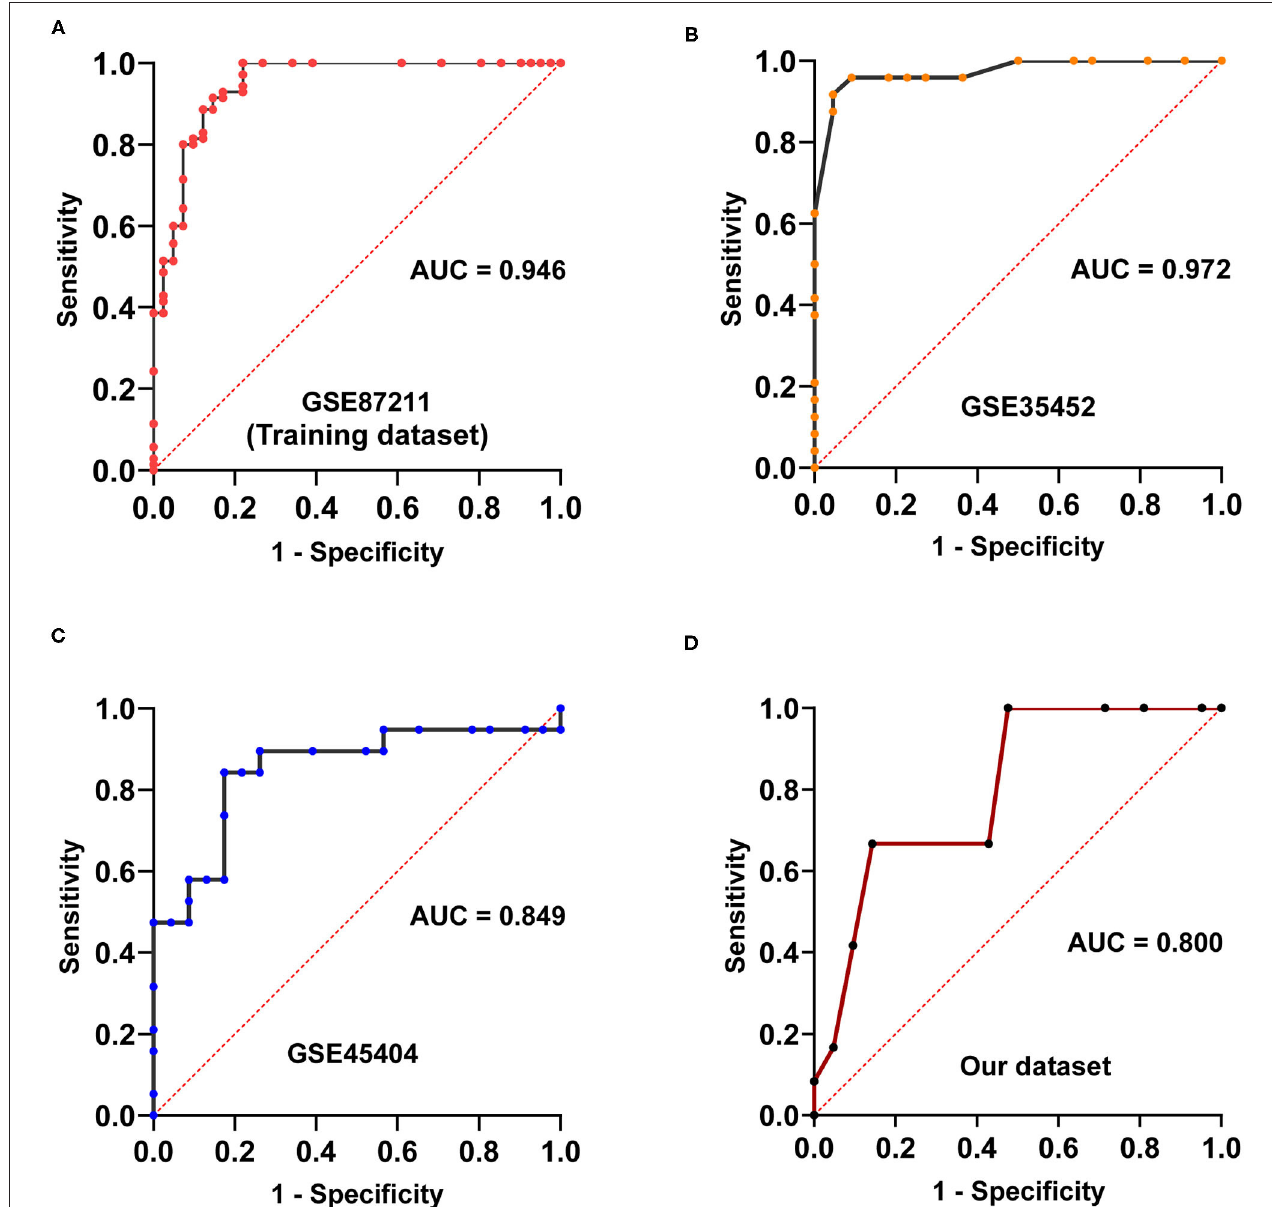
FIGURE 4 | Area under receiver characteristic operating curves of four cohorts. (A) Area under receiver characteristic operating curves of GSE87211. (B) Area under receiver characteristic operating curves of GSE35452. (C) Area under receiver characteristic operating curves of GSE45404. (D) Area under receiver characteristic operating curves of the dataset measured in our